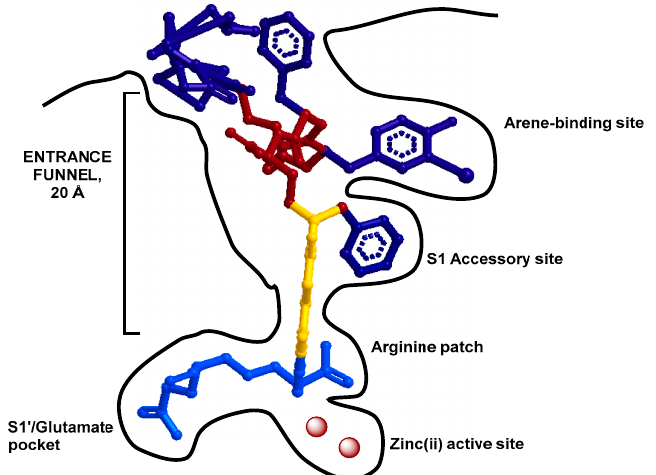
Figure 1. Schematic interactions between a Glu-ureido–based ligand and the PSMA binding cavity [31].